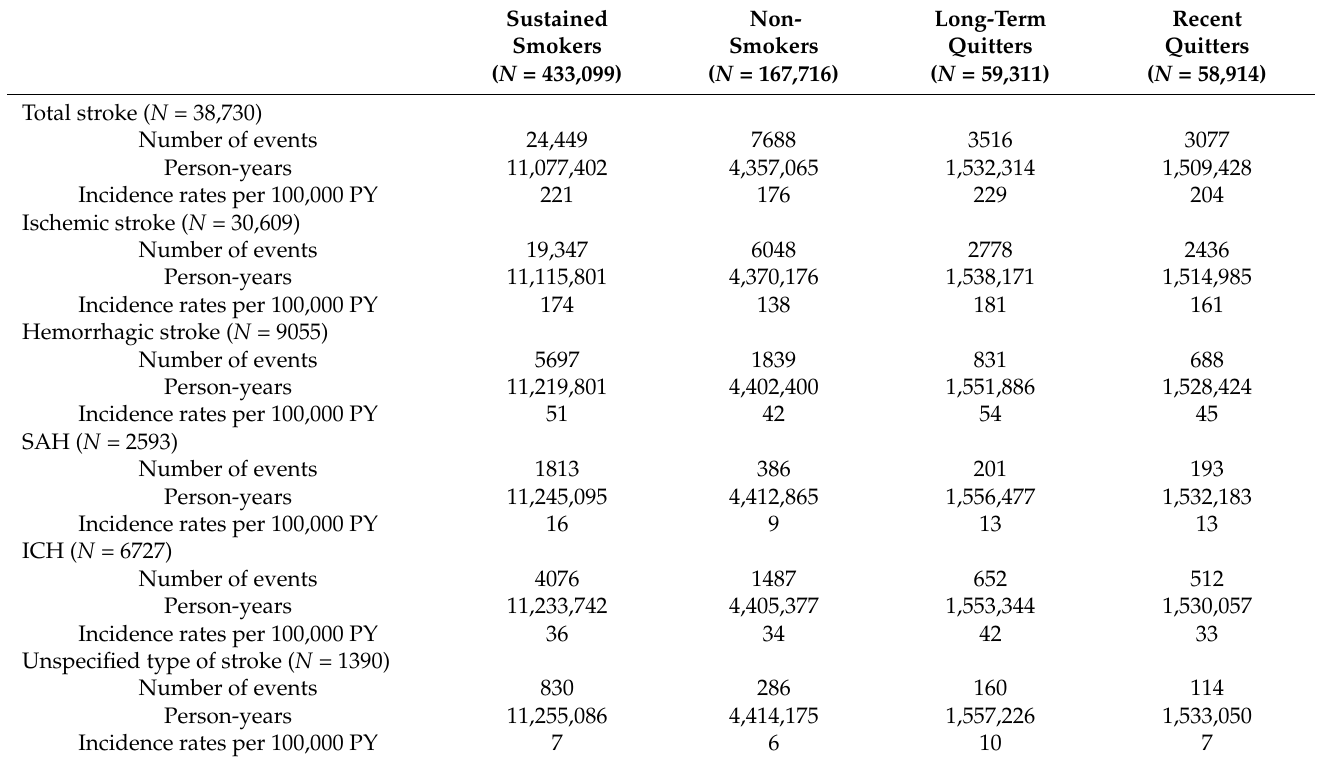
Table 2. Incidence rates of stroke and its subtypes (per 100,000 person-years) according to smoking cessation in Korean